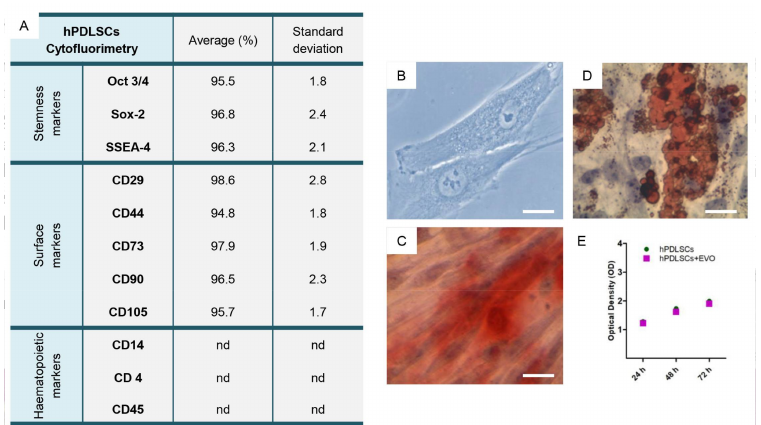
Figure 1. Primary culture and phenotypic characterization of human periodontal ligament stem cells (hPDLSCs). ( A ) The phenotypic profile of hPDLSCs. ( B ) hPDLSCs in the primary culture stained with toluidine blue solution. ( C ) hPDLSCs under osteogenic culture conditions stained with Alizarin Red S. ( D ) hPDLSCs under adipogenic culture conditions stained with Adipo Oil red O. ( E ) The proliferation rate evaluated by means (3-(4,5-dimethylthiazol-2-yl)-2,5-diphenyltetrazolium bromide) tetrazolium reduction (MTT) assay in hPDLSCs and hPDLSCs + EVO. nd: not detectable. Magnification (Mag): 40 × . Scale bars: 50 µ m.